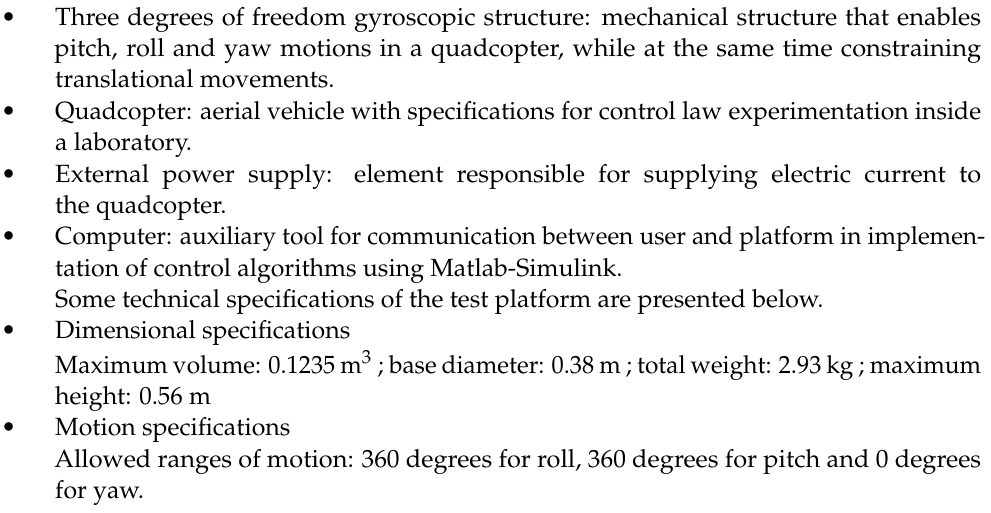
Figure 1. Experimental prototype of three degrees of freedom for validation of control algorithms in quadcopter